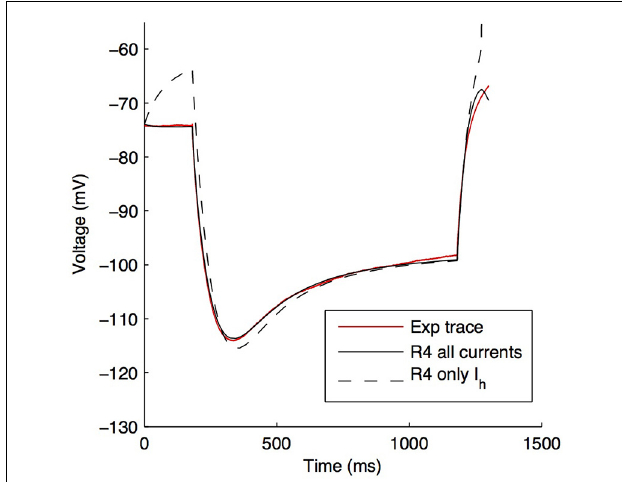
FIGURE 7 | O-LM model response to − 90pA hyperpolarizing current changes when all active voltage-gated channels, except I h , are blocked. Somatic voltage traces in response to a − 90pA current injection step for experimental cell 4525#4 (solid red), optimized model R4 with all ion channels active (solid black) and optimized model R4 with only I h active, with other channels blocked (dashed black).